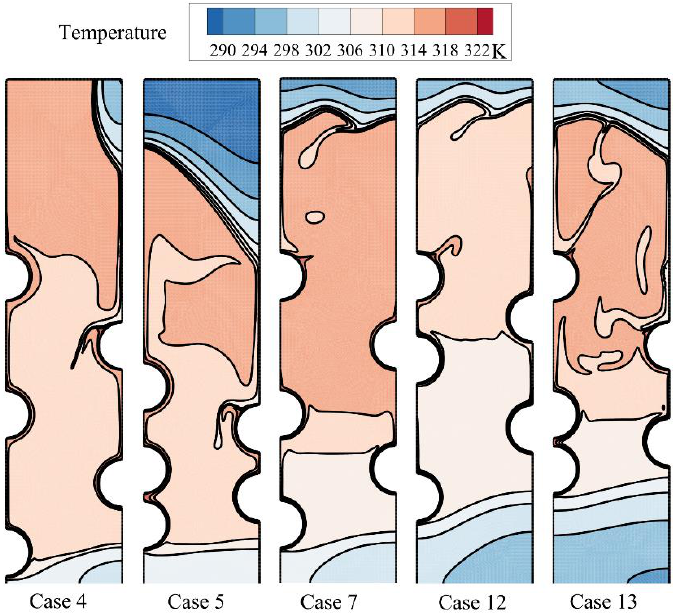
Figure 11. The isotherms for five different tubes ’ arrangement after three hours of charging.